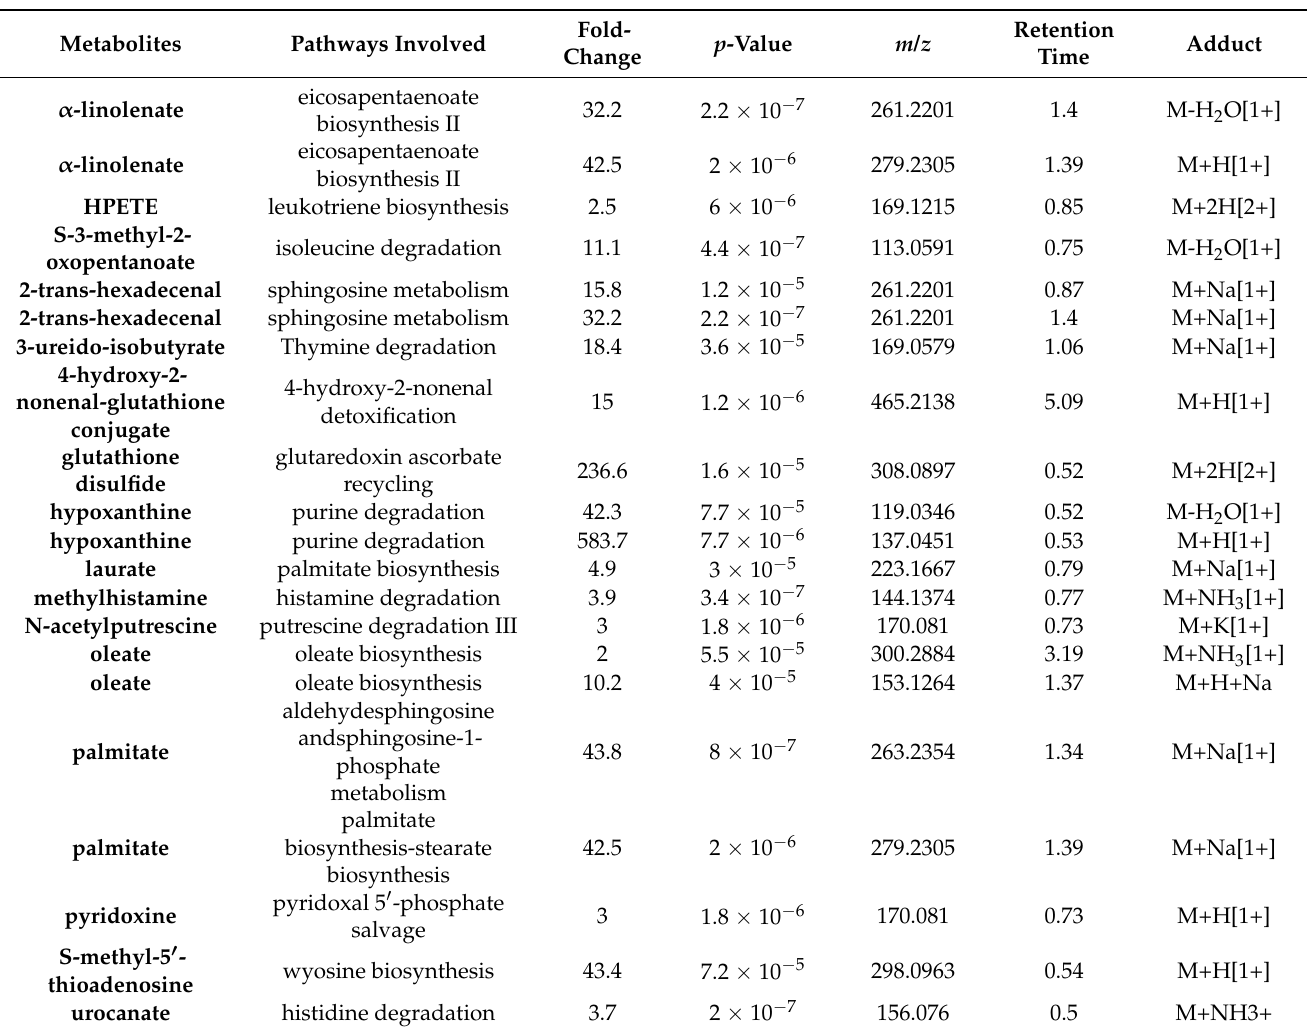
Table 1. Metabolites significantly upregulated after 24 h safranal treatment in pellet extracts involved in critical metabolic